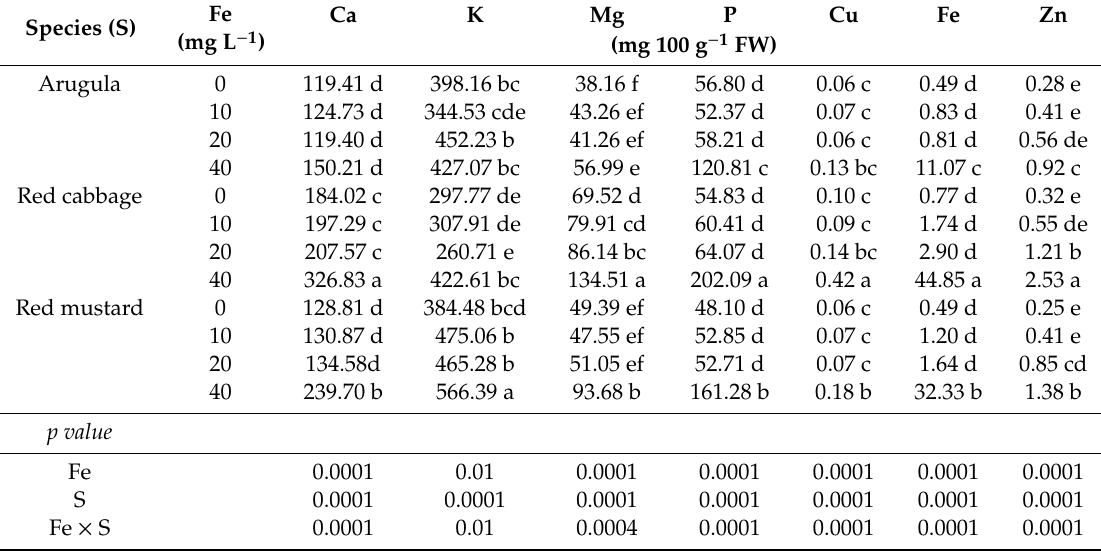
Table 4. Nutrient solution iron (Fe) level e ff ects on the concentration (mg 100 g − 1 FW) of calcium (Ca), potassium (K), magnesium (Mg), phosphorous (P), copper (Cu), Fe, and zinc (Zn) in arugula, red cabbage, and red mustard microgreens 1